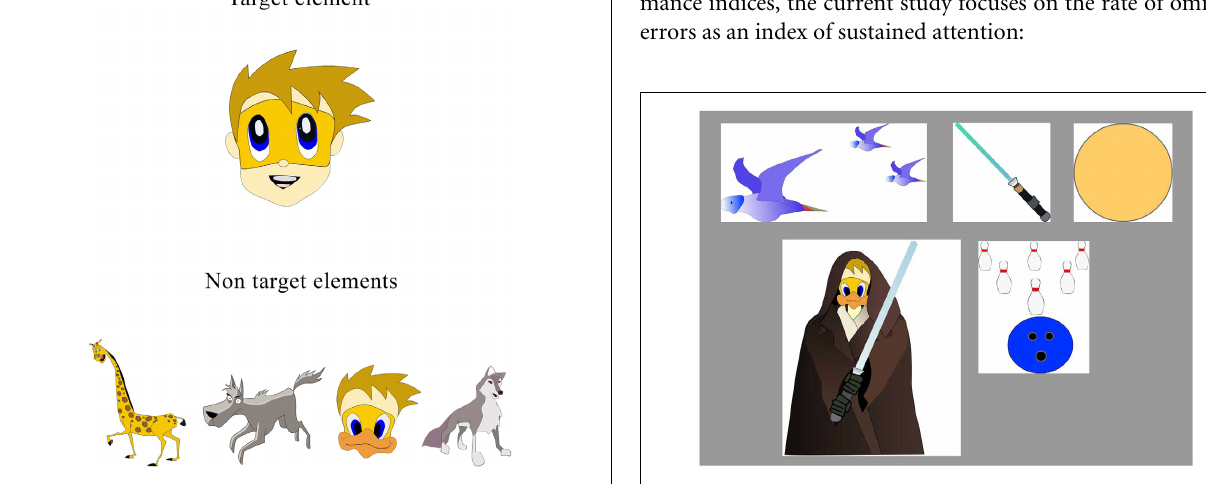
FIGURE 2 | MOXO-CPT target and non-target stimuli. FIGURE 3 | MOXO-CPT visual